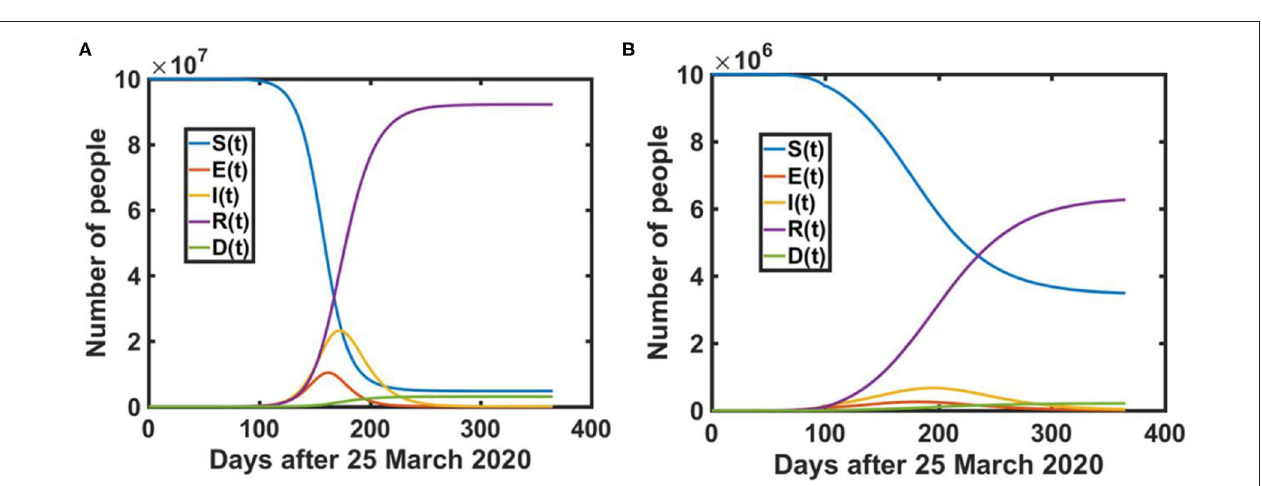
FIGURE 7 | Mathematical model prediction of COVID-19 dissemination in India under (A) without lockdown (B) Lockdown of 100 days. The incubation period and recovery rate are taken as 5.2 days (incubation rate = 1/5.2 day − 1 ) is 0.7012 day − 1 respectively.